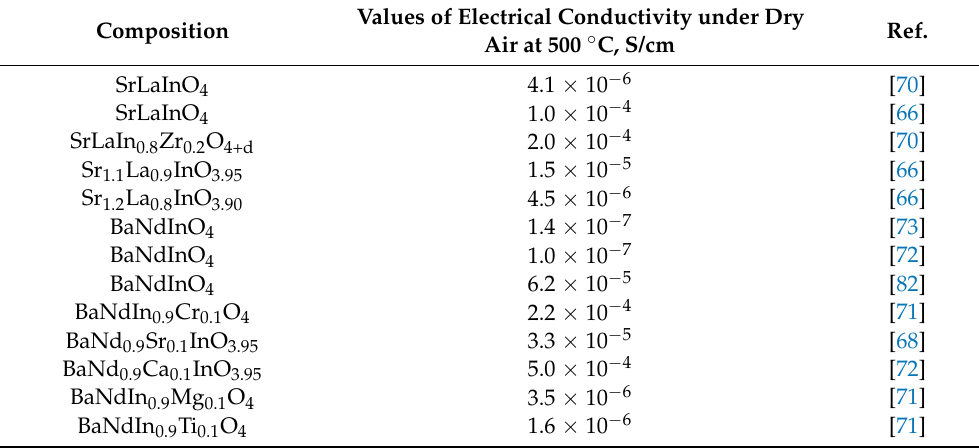
Table 3. The comparison of the electrical conductivity values of phases with Ruddlesden– Popper